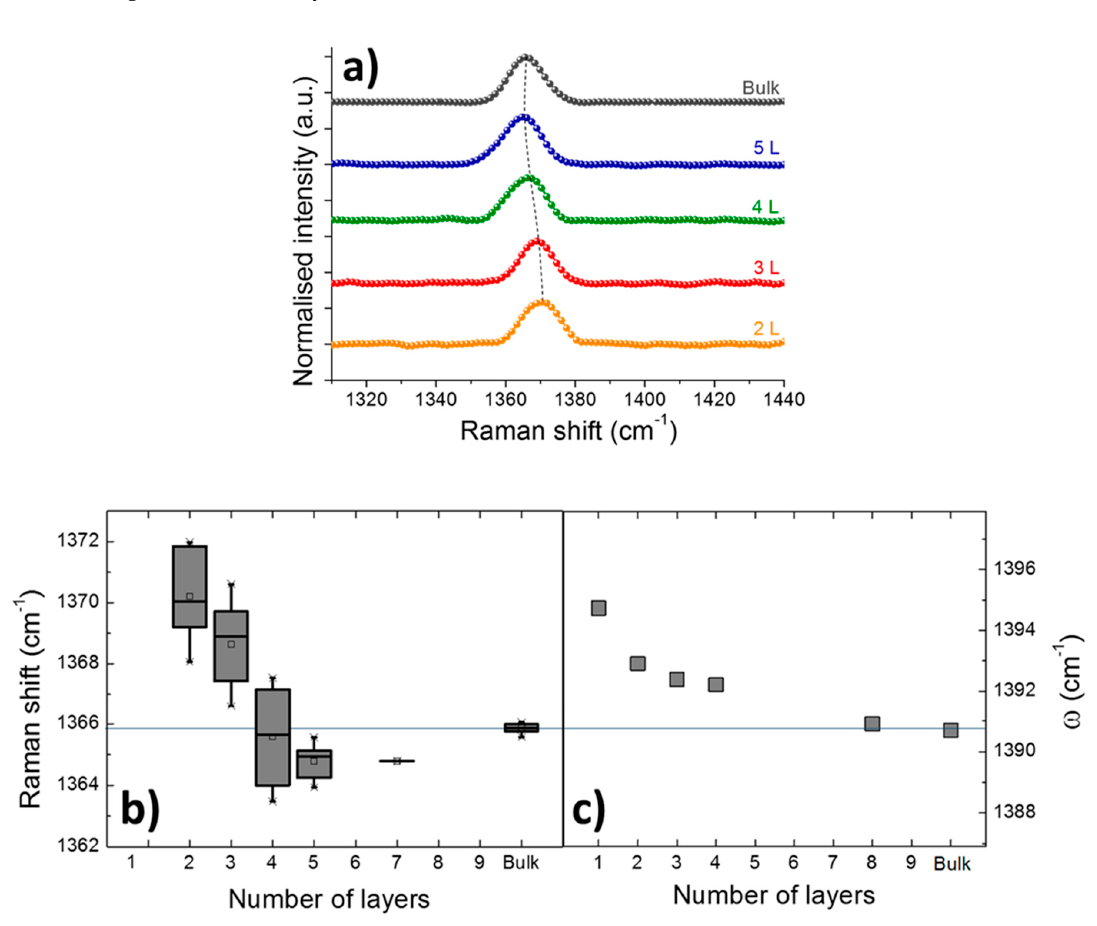
Figure 4. ( a ) Normalized Raman spectra of hBN crystals with thickness varying from 2 to 5 layers and bulk. The spectra are averaged by 6 measurements (2 L), 10 measurements (3 L), 4 measurements (4 L), 14 measurements (5 L) and 19 measurements (bulk). ( b ) Raman shift of the E 2g phonon frequencies and ( c ) calculated phonon frequencies ( ω ) as a function of the number of monolayers. ( b ) is experimentally measured values.